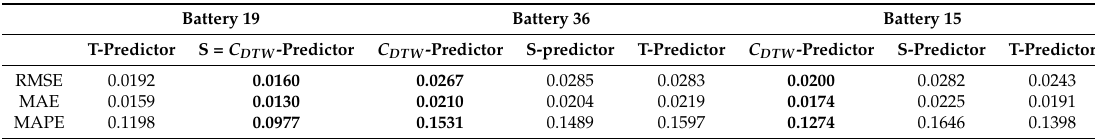
Table 7. ARIMA performance comparison of Dynamic Time Warping (DTW) Clustered predictor ( C DTW ), Single predictor (S), and Total predictor (T) .